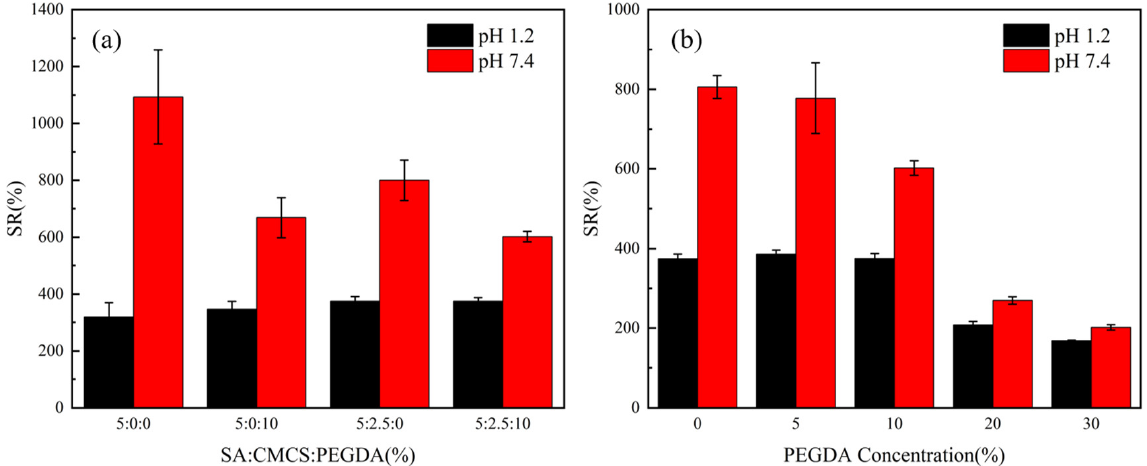
Figure 5. ( a ) Swelling rate of hydrogels containing SA, CMCS, and PEGDA that possess different proportions. ( b ) Swelling rate of hydrogels with various concentrations of PEGDA.